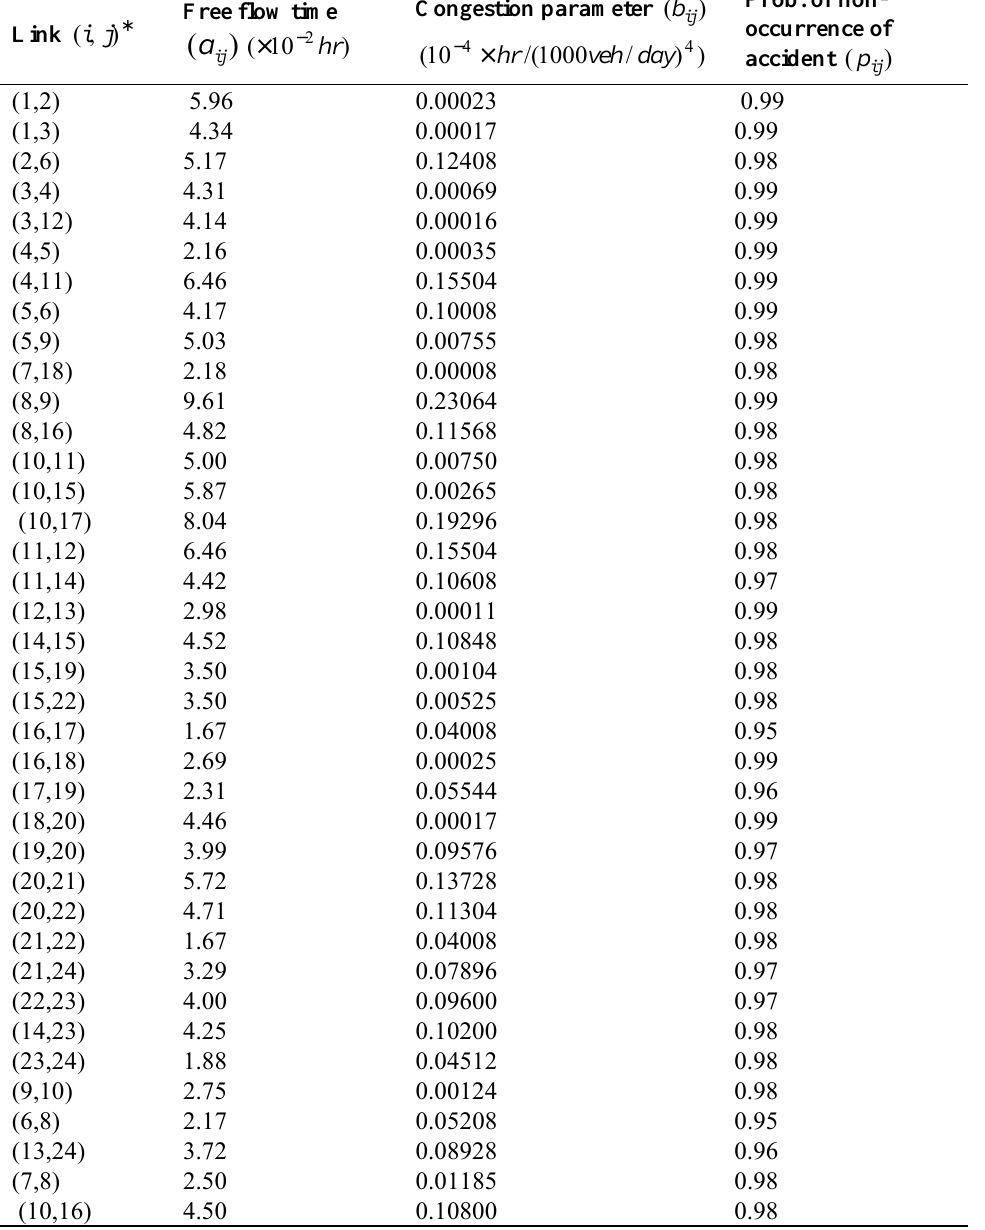
Table 4. Specifications of the links of Example Network 2.